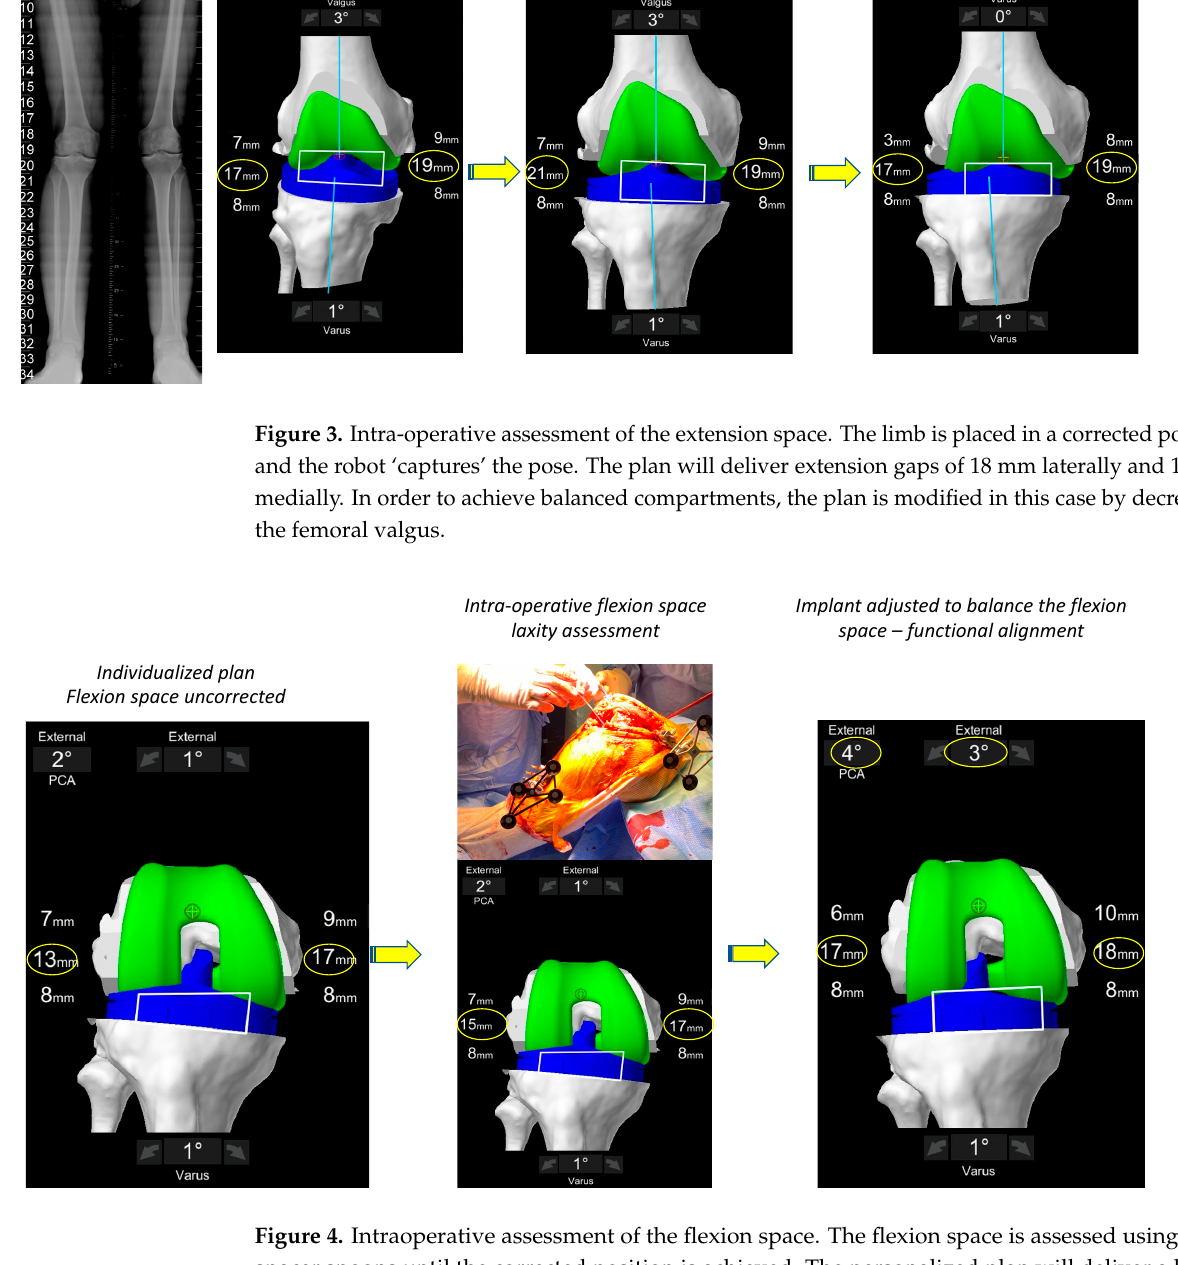
Figure 4. Intraoperative assessment of the flexion space. The flexion space is assessed using sized spacer spoons until the corrected position is achieved. The personalized plan will deliver a lateral space of 17 mm and a medial space of 18 mm. In order to balance the flexion space, the implant is externally rotated until the compartments are balanced.